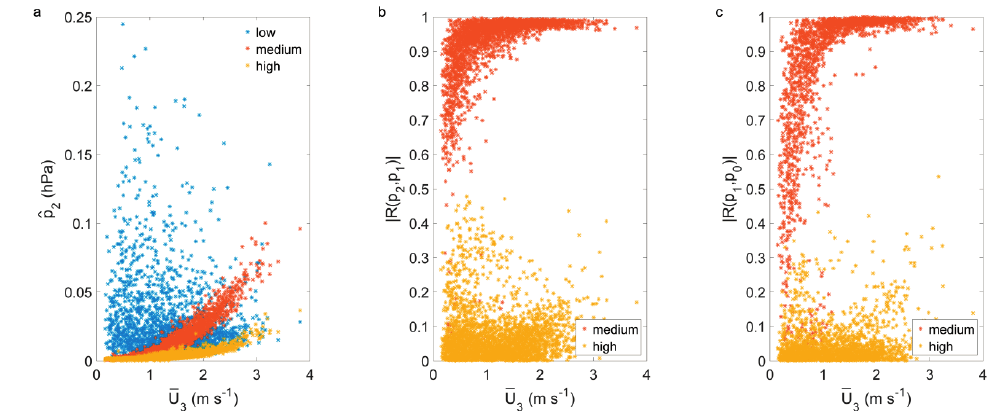
Figure 4. Dependence of ( a ) the amplitudes of the air pressure signal measured at height (cid:1878) (cid:2870) ( (cid:1868)̂ (cid:2870) ); ( b ) the absolute correlation coefficient between the air pressure signals at heights (cid:1878) (cid:2870) and (cid:1878) (cid:2869) ( |(cid:1844)((cid:1868) (cid:2870) ,(cid:1868) (cid:2869) )| ); and ( c ) the absolute correlation coefficient between the air pressure signals at heights (cid:1878) (cid:2869) and (cid:1878) (cid:2868) ( |(cid:1844)((cid:1868) (cid:2869) , (cid:1868) (cid:2868) )| ) on mean above-canopy wind speed ( (cid:1847)(cid:3365) (cid:2871) ) for different frequency ranges (low, medium,